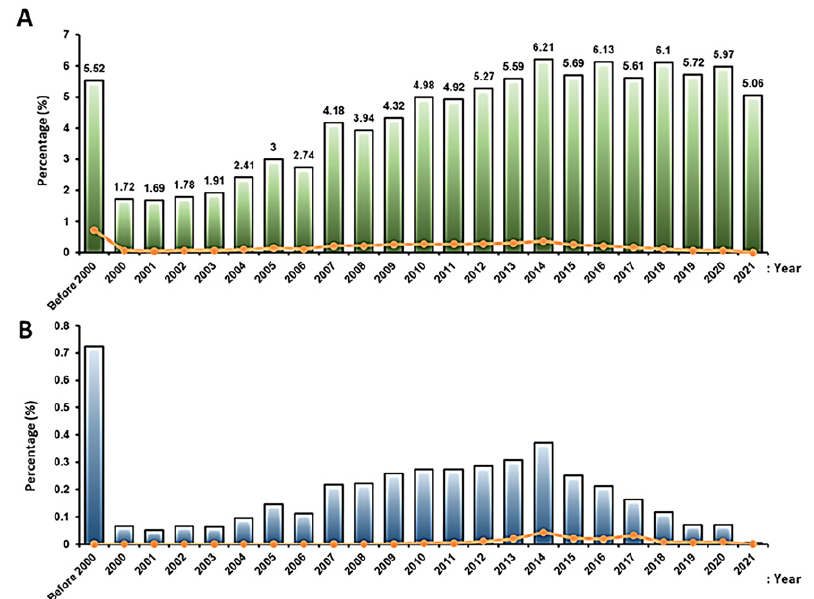
Figure 8. The proportion of clinical trials using stem cells by year: ( A ) the proportion of new clinical trial studies using stem cells by year (green bar) and the proportion of registration results accordingly (orange color line); ( B ) the proportion of completed registered clinical trial studies using stem cells by year (blue bar) and the updated results of completed clinical trial studies using stem cells by year (orange line).